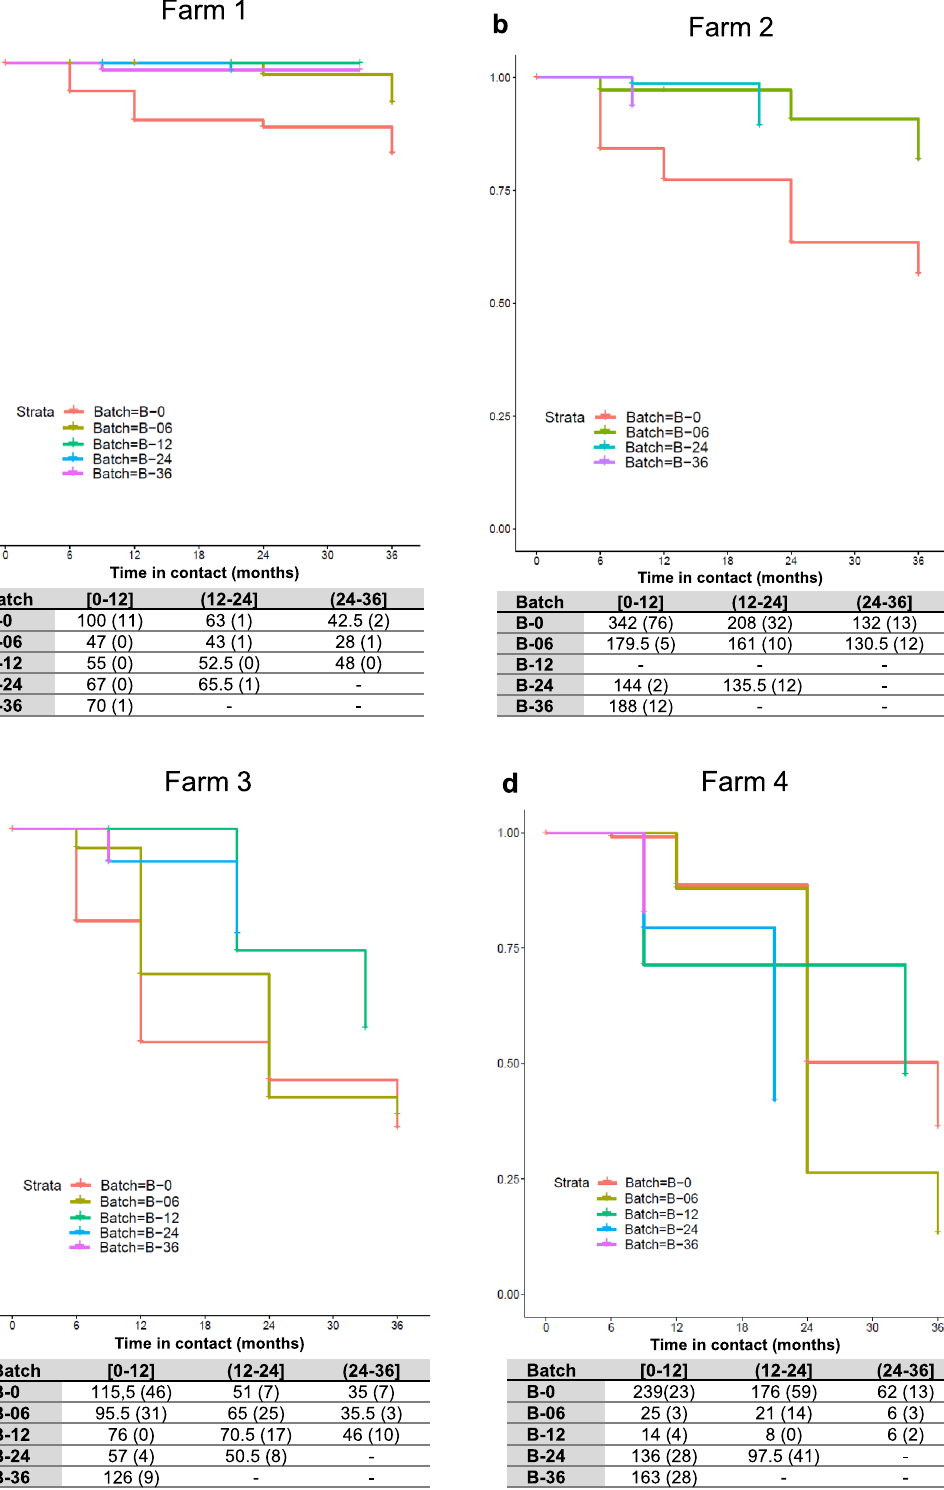
Figure 3. TB Incidence in BCG vaccinated batches from farms 1 ( a ), 2 ( b ), 3 ( c ), 4 ( d ) and 5 ( e ) throughout the trial. Proportion of TB negative animals (y axis) throughout the time in contact (x axis) with the TB positive herd in months. The table represents the incidence of TB in each batch (B) depending on the time in contact, between 0 and 12 months ([0–12]), more than 12–24 months ((12–24]) and more than 24–36 months ((24–36]). The animals at risk, which were the TB negative animals between sampling time points (some animals were slaughtered or died between periods. Those animals were considered present during the half of the period and its number was divided by two). In parenthesis are represented the number of TB new positive goats during a given